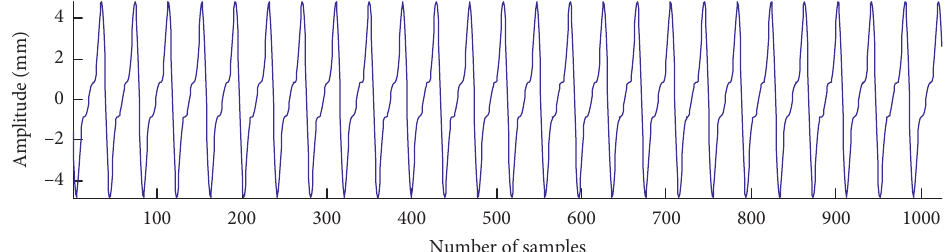
Figure 1: The vibration signal of rotor